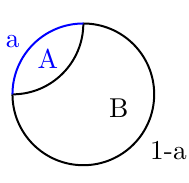
Figure 1 . Bipartition of constant time slice of thermal AdS 3